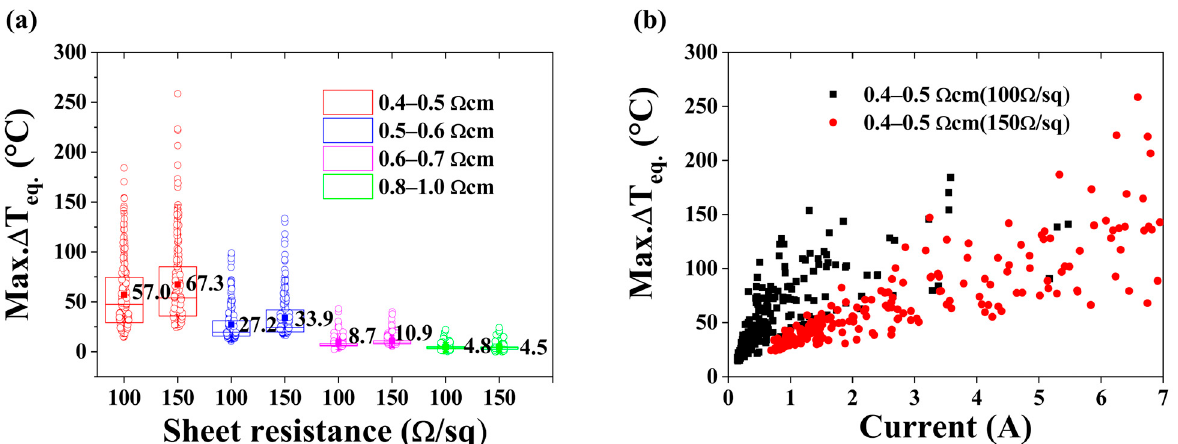
Figure 2. ( a ) Boxplots of the 𝑀𝑎𝑥∆𝑇 (cid:3032)(cid:3044). values of the gallium-doped PERC cells under different re- Figure 2. ( a ) Boxplots of the Max ∆ T eq . values of the gallium‑doped PERC cells under different resis‑ sistivities and sheet resistance conditions. ( b ) Correlation scatter plot of the reverse leakage current tivities and sheet resistance conditions. ( b ) Correlation scatter plot of the reverse leakage current and and 𝑀𝑎𝑥∆𝑇 (cid:3032)(cid:3044). under − 15 V reverse bias when the resistivity was 0.4 – 0.5 Ω cm, and the sheet re- Max ∆ T eq . under − 15 V reverse bias when the resistivity was 0.4–0.5 Ω cm, and the sheet resistance sistance was 100 Ω /sq and 150 Ω /sq. was 100 Ω /sq and 150 Ω